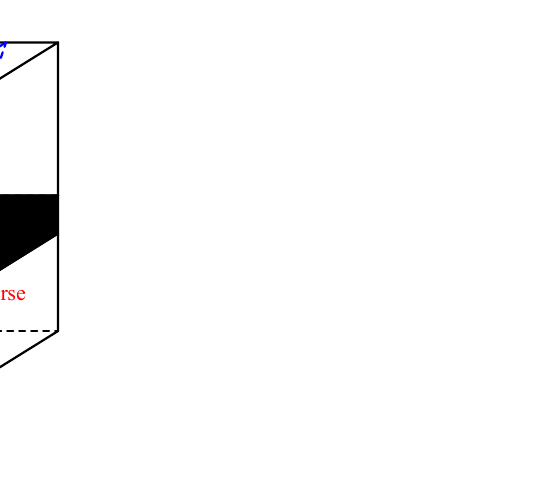
Figure 8. Experimental blasting test